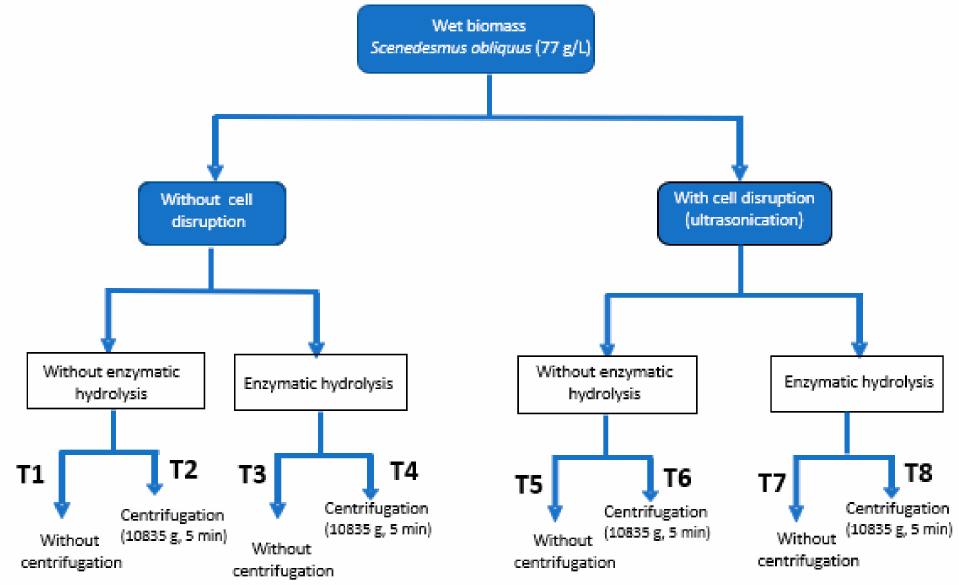
Figure 5. Downstream processing of the fresh microalgal biomass (cell rupture by ultrasounds, enzymatic hydrolysis and centrifugation). For each treatment di ff erent concentrations were tested (0.1, 0.5 and 2 g / L depending on the